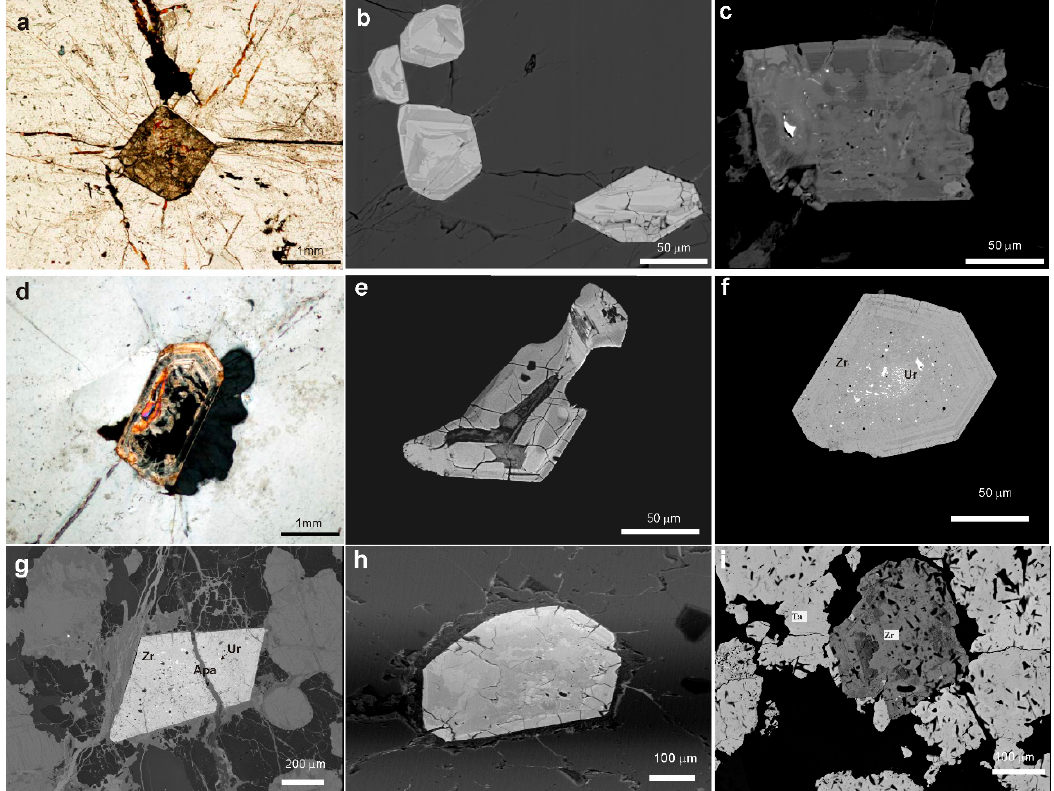
Figure 10. Textural patterns of zircon in type-III pegmatites. ( a ) Transmitted optical microscope image of zircon crystal included in plagioclase showing radial fractures produced during metamictisation, PPL. ( b ) Euhedral zoned zircon crystals. SEM image, BSE mode. ( c ) zircon crystal with convoluted zoning. SEM image, BSE mode. ( d – g ) Textural patterns of zircon in type-IV pegmatites. ( d )